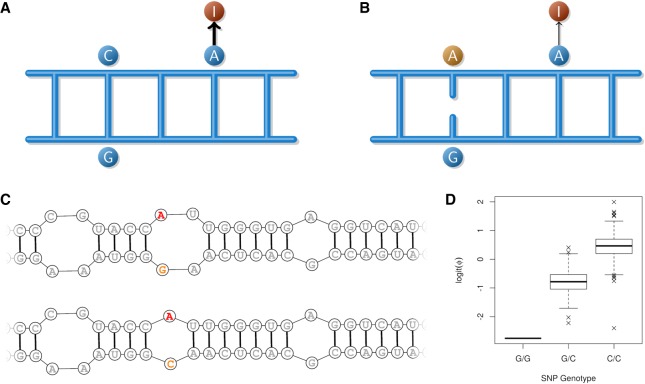
Graphical illustration of the mechanistic hypothesis that reducing sequence complementarity will decrease rates of editing. (A) A short double-stranded section of an mRNA secondary structure, containing a SNP (C) with complementary base (G), and an adjacent editing site (A), with high levels of editing. (B) The alternative SNP allele (A) reduces complementarity, destabilizing the secondary structure with a consequent reduction in editing rates. Panel C shows a site (Chr19.9446387.AG.LPO) in the lactoperoxidase gene exemplifying this scenario. In this case, the edit site (red) is directly opposite the candidate modulatory G/C SNP (rs133364759; orange), being highly associated with editing frequency (Φ). The “G” allele of this SNP is predicted to reduce the stability of the double-stranded helix adjacent to the edit site, with a predicted altered secondary structure and consequent reduction in the rate of editing (D).